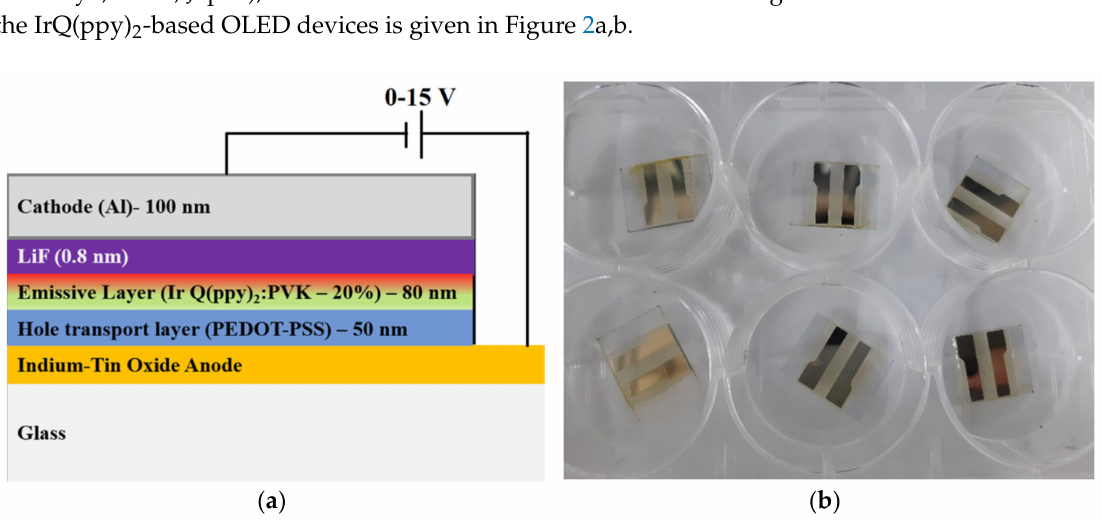
Figure 2. Final structure ( a ) and devices of IrQ(ppy) 2 -based devices ( b